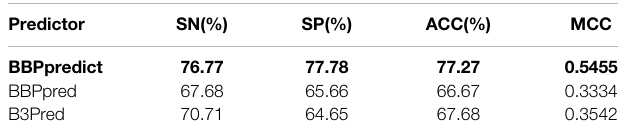
TABLE 5 | The prediction performances of different